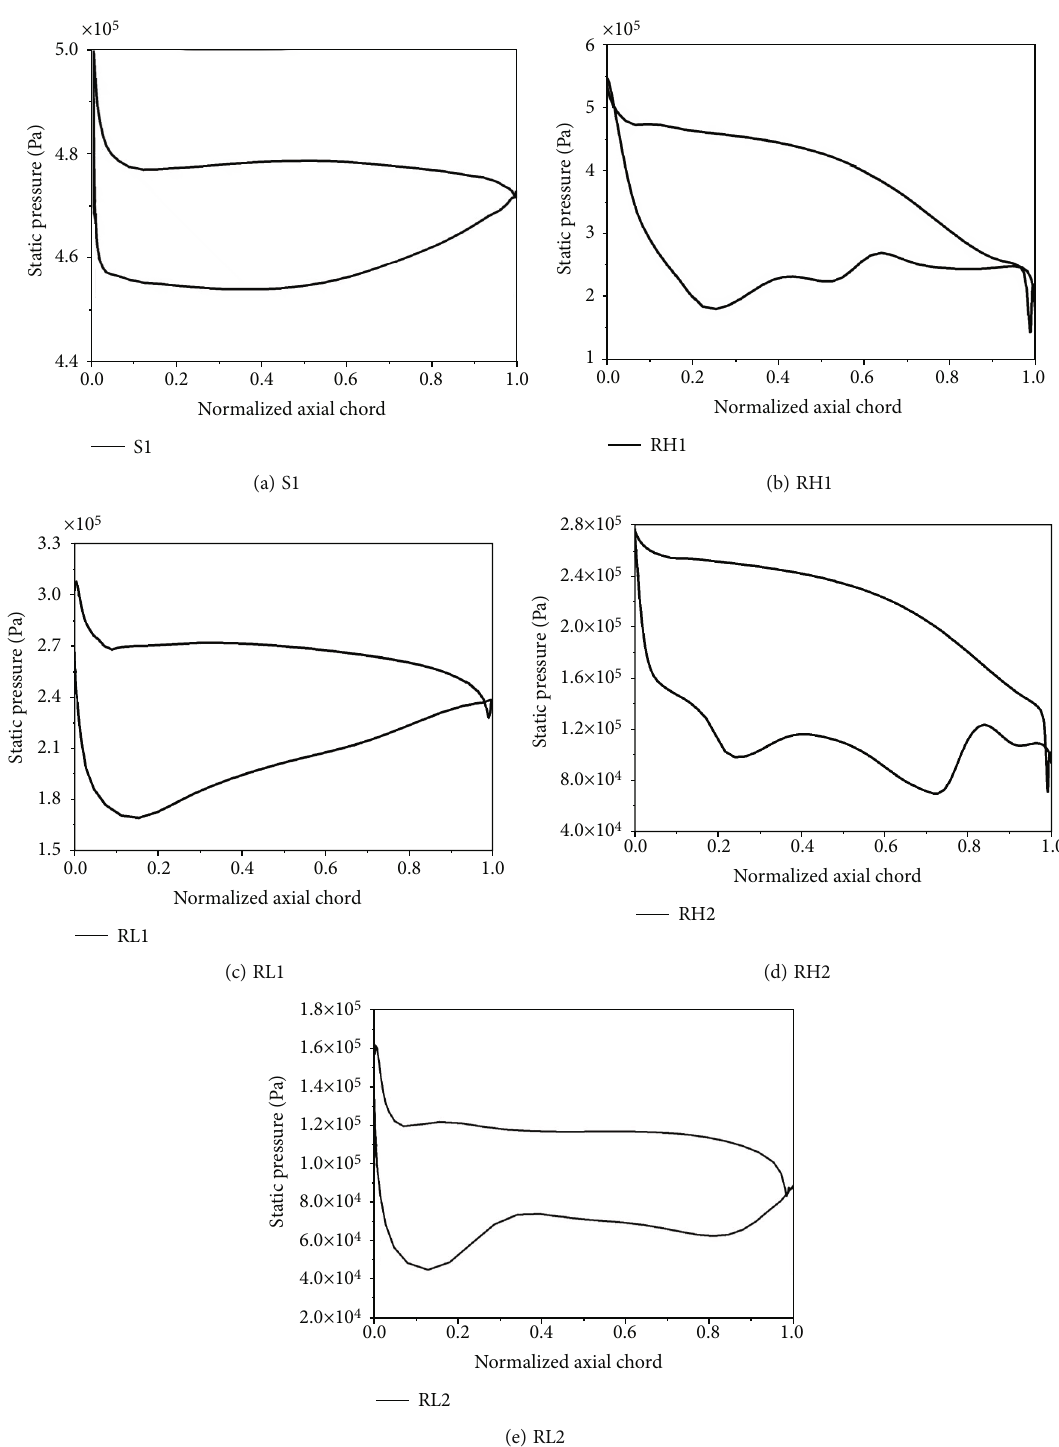
Figure 12: Static pressure